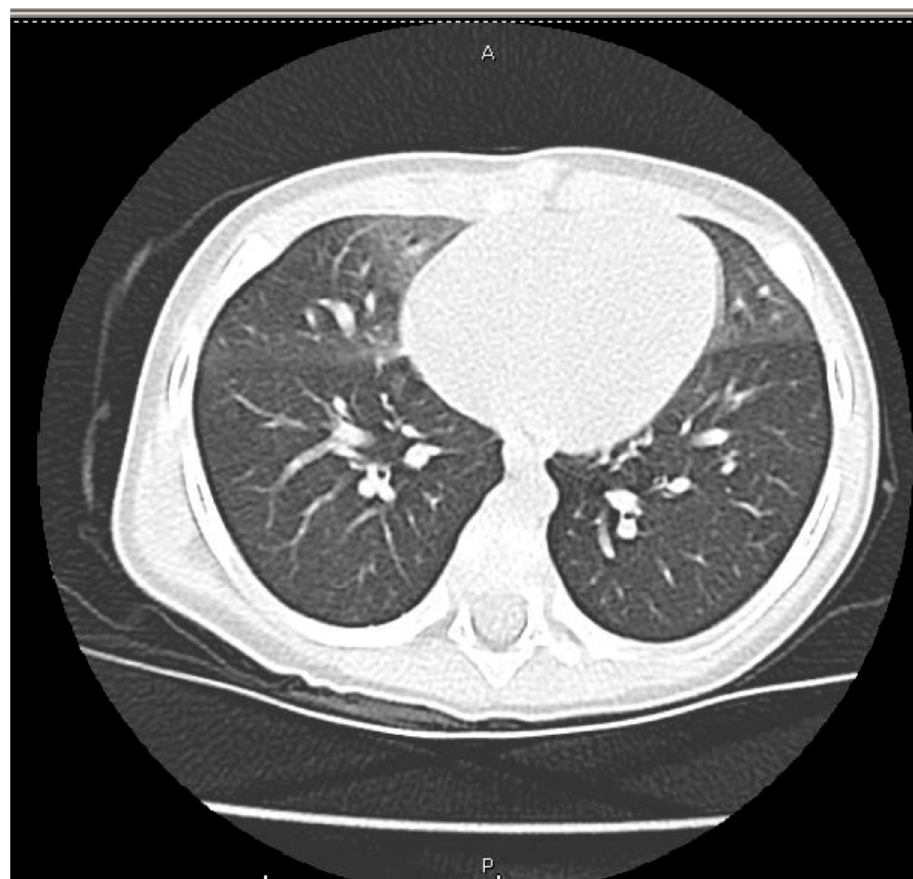
Figure 2. High-resolution chest computed tomography (CT) documenting patchy areas of ground-glass opacity involving the right upper lobe, middle lobe, and lingula, as well as mosaic areas of air-trapping, which are suggestive of a diagnosis of neuroendocrine cell hyperplasia of infancy (NEHI). A: anterior, P: posterior.